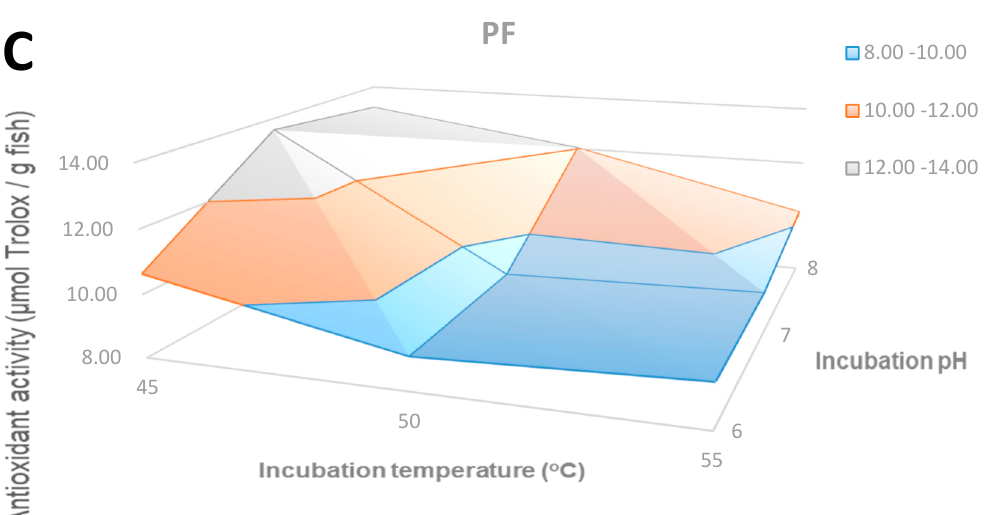
Figure 4. The antioxidant activity of hydrolysates by the ORAC method: ( A ) HT hydrolysate; ( B ) PAL hydrolysate; ( C ) PF hydrolysate.